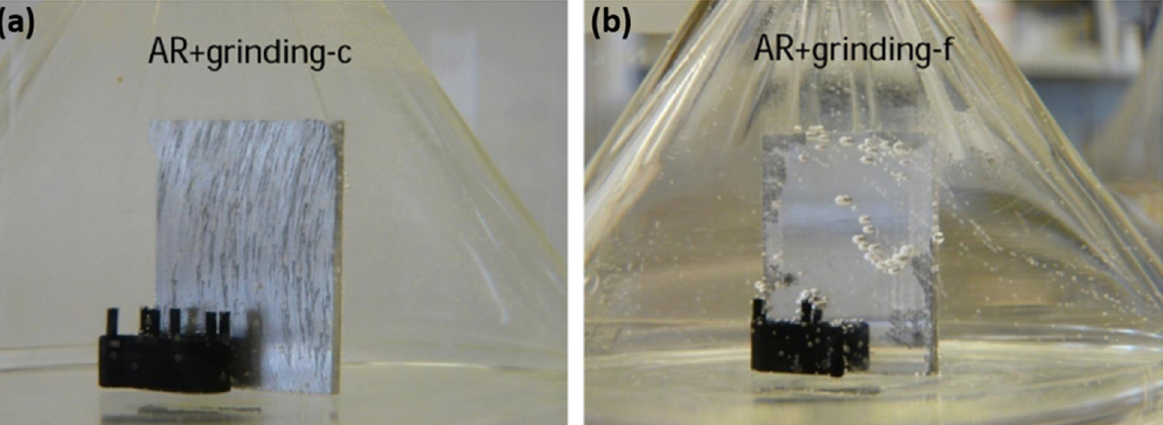
Figure 2. The in situ observation of the corrosion morphologies of the AZ31 magnesium sample ground with ( a ) SiC paper (marked as AR+grinding-c); ( b ) polished up to 1 µm diamond paste (marked as AR+grinding-f) in 5 wt.% NaCl [14]. “AR” stands for “as-received”. Reprinted from [14]